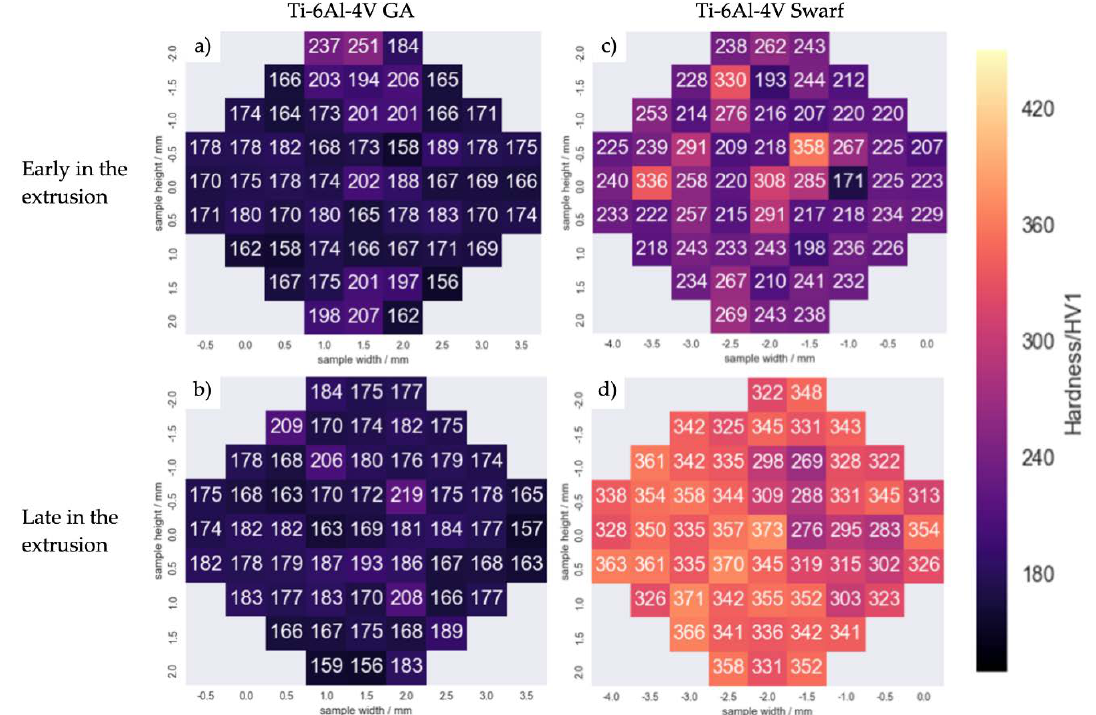
Figure 15. The microhardness of the cross-section material. ( a , b ) Recorded from the cross-section of the Ti-6Al-4V GA wire; ( c , d ) taken from the Ti-6Al-4V swarf wire. ( a , c ) From the initial extrusion; ( b , d ) the last material to be extruded during a trial.